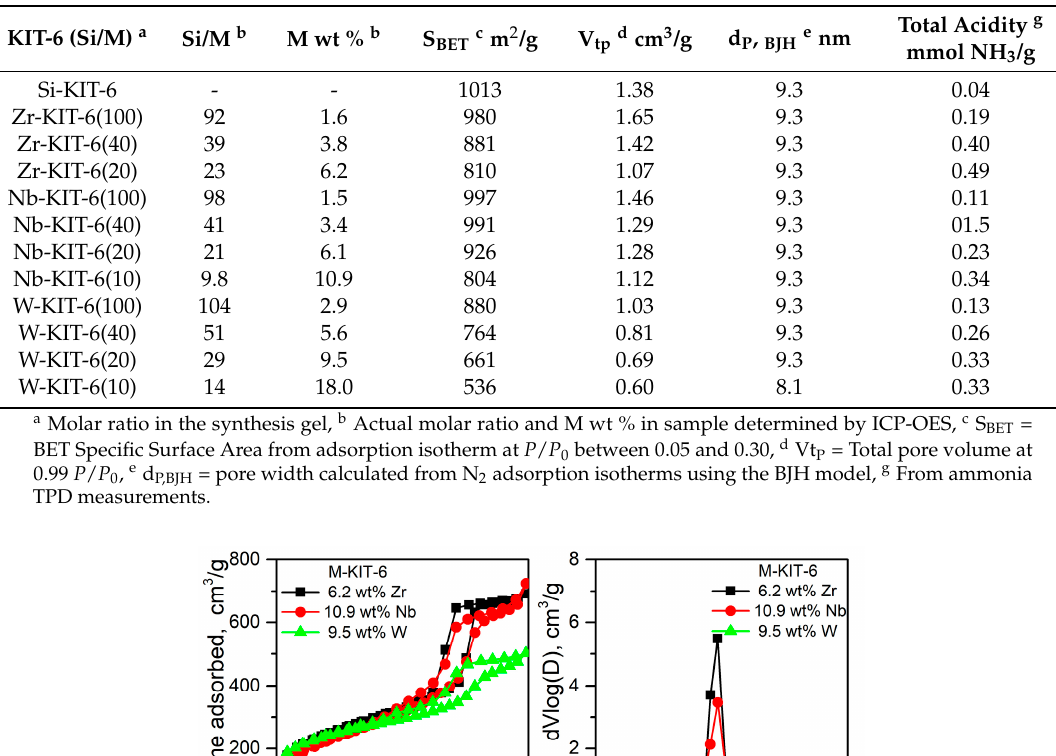
Table 1. Physicochemical properties of M-KIT-6 catalysts.